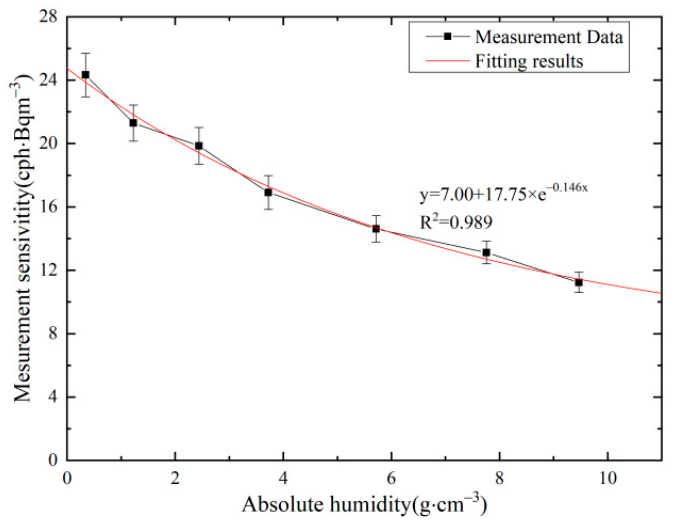
Figure 5. Calibration results of the relationship between sensitivity and absolute